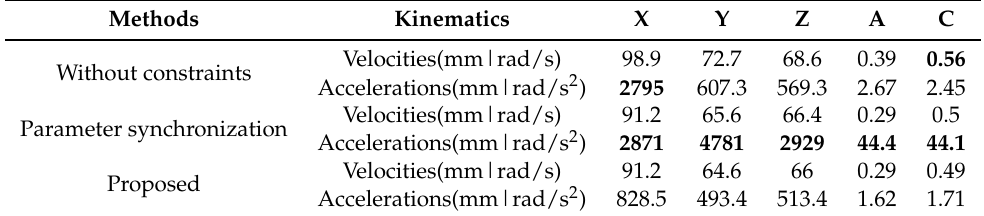
Figure 18. Proposed axial velocities and accelerations—( a ) Translational axial velocities. ( b ) Rotary axial velocities. ( c ) Translational axial accelerations. ( d ) Rotary axial accelerations. Table 2. Maximum axial velocities and accelerationsusing different methods.